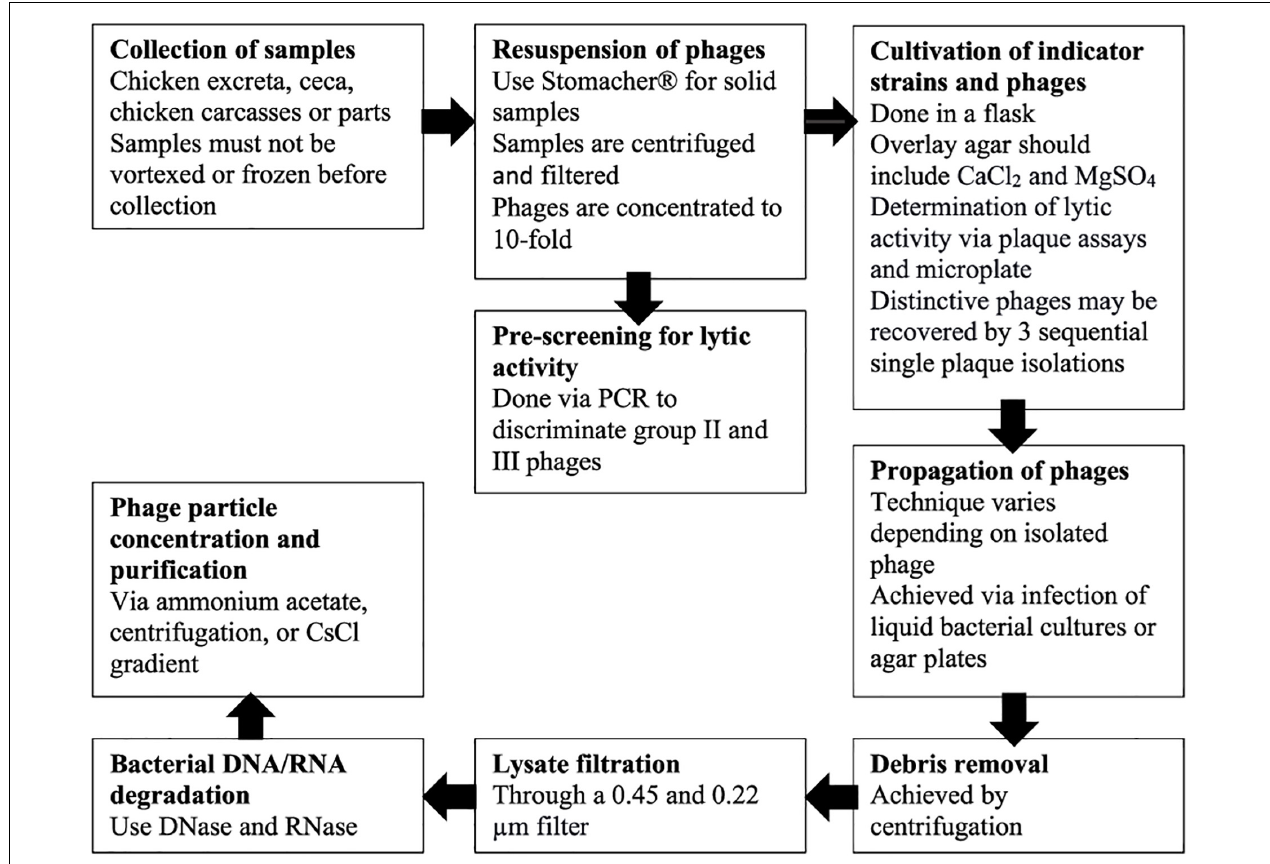
FIGURE 1 | Outline of main concepts of isolation, propagation, concentration, and purification of Campylobacter